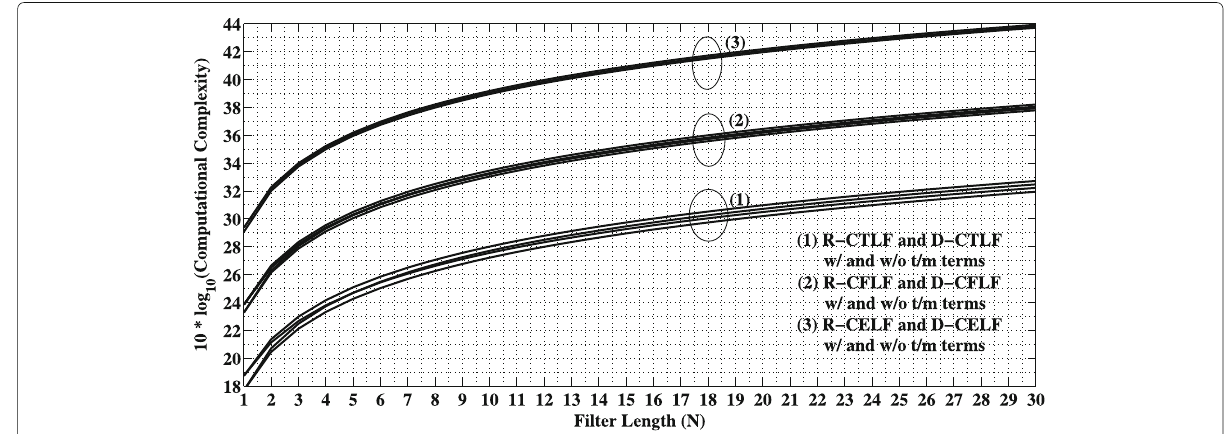
Fig. 9 Computational complexity comparison of the proposed schemes for different values of M